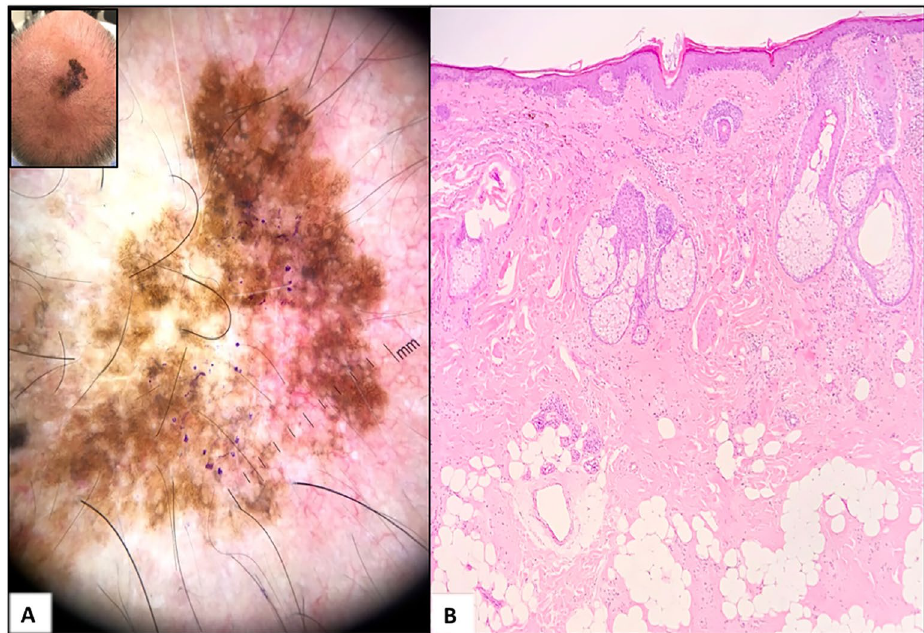
Figure 4. Case of a 58-years-old man with severe androgenetic alopecia and an atypical melanocytic lesion in an area without hair; ( A ) Dermoscopic image showing a classic dermoscopic pattern (regression structures and peripheral tan structureless areas) and a photodamaged dermoscopic pattern (perifollicular granularity; gray, asymmetric perifollicular openings; polygonal and rhomboidal structures; follicle obliteration; concentric circles; and angulated lines); ( B ) Histopathological examination showing a lentigo maligna with severe elastosis and signs of androgenetic alopecia on the tumor